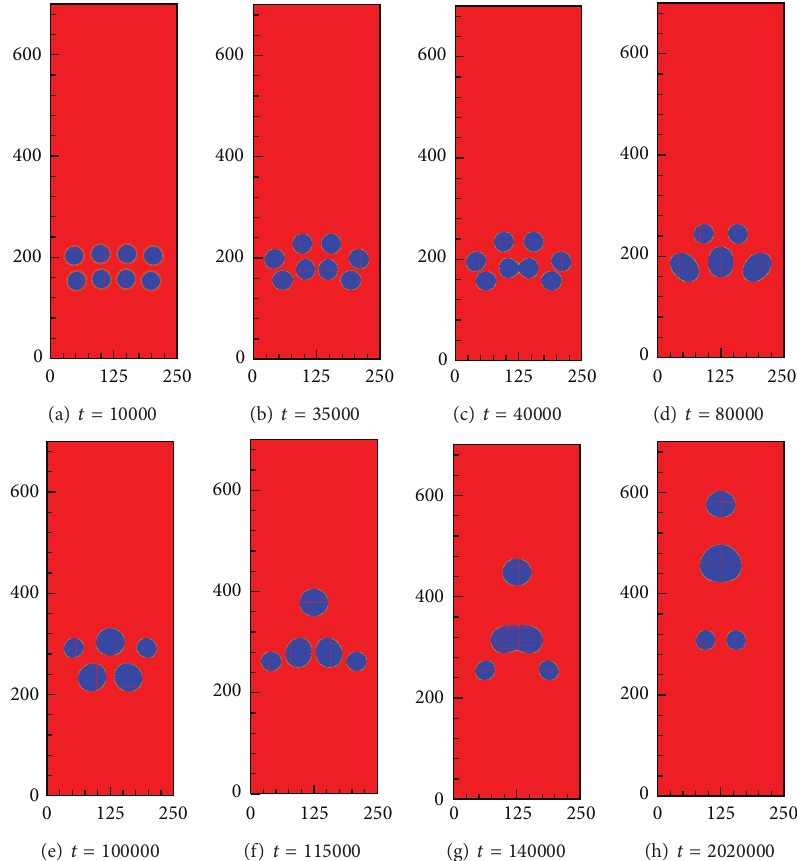
Figure 12: The contour of order parameter of eight bubbles for Eo = 1